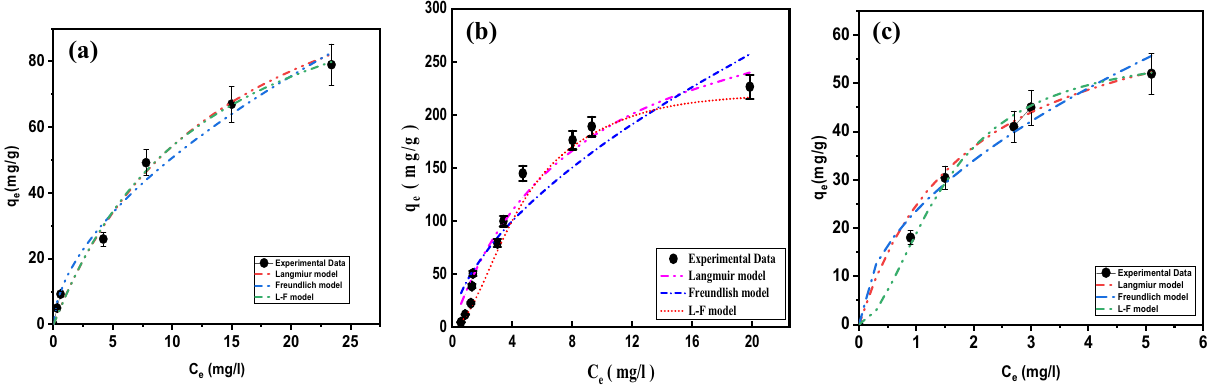
Figure 12. Experimental adsorption isotherm data of ( a ) MB, ( b ) MO, and ( c ) MG dye on LDH fitted using two- and three-parameter isotherms.